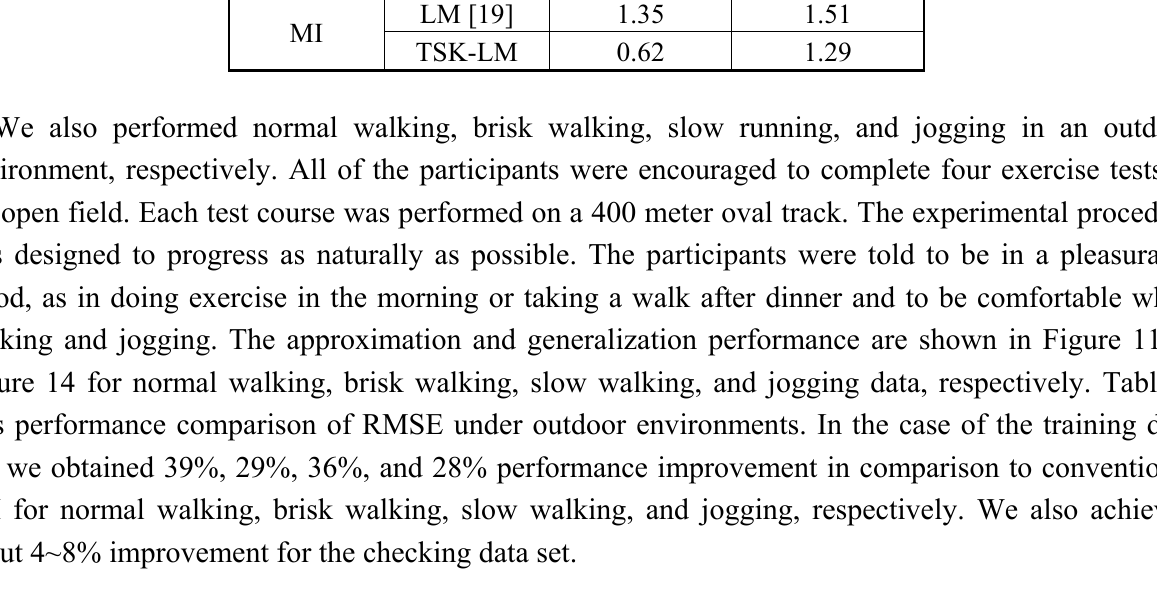
Figure 11. Approximation and generalization capability for normal walking